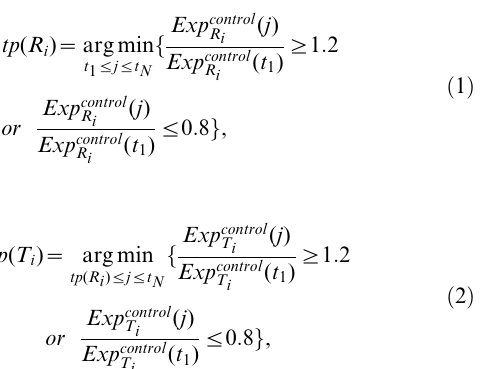
Figure 1. Workflow of our approach. The figure shows the workflow of our approach. Given the time-series gene expression datasets of the case and the control group, 15 deregulated genes are selected to map to the nodes of KEGG human regulatory network G . Allowing for the integrity of links among genes, we construct the differentially regulated network DG consisting of 17 nodes and 25 directed edges. For each regulator-target gene pair, we compute the regulatory strength of the control (colored by blue) and the case (colored by red) and the two weighted differentially regulated network DG control and DG case are constructed. Centered on the seed gene ‘g10’, which is colored by yellow, the two regulatory subsystems RS control and RS case are extracted. The deregulated module is derived by integrating the differential edges of the CCRPs. Here, the CCRP from ‘g4’ to ‘g11’ is switched. In the control group, the CCRP is ‘g4 R g7 R g10 R g11’. While in the case group, it is ‘g4 R g10 R g16 R g11’.